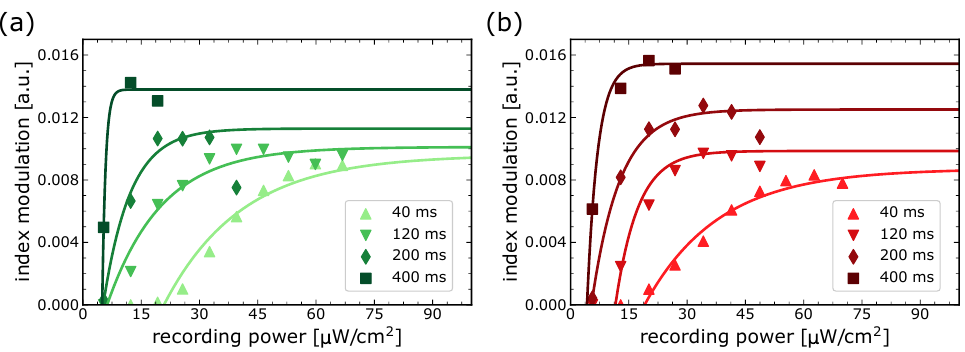
Figure 6. Derived index modulation values according to Equation (5) for holograms recorded in the green ( a ) and red ( b ) spectral